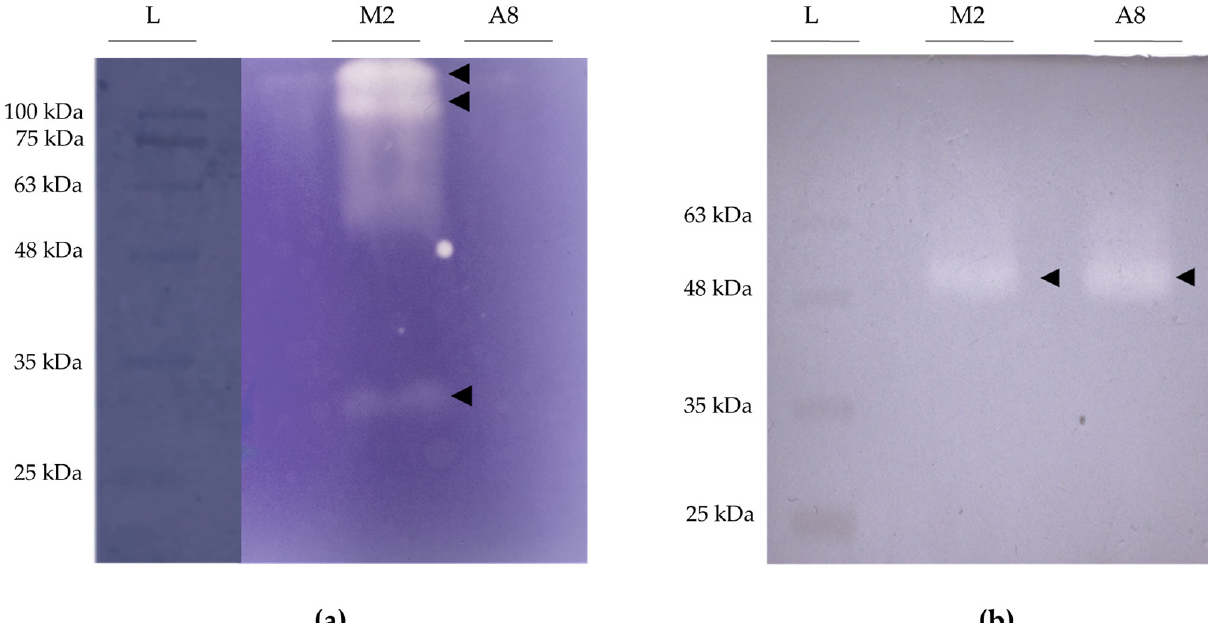
Figure 1. Detection by zymography of proteases and lipases secreted by B. peudobassiana RGM 2184. ( a ) Gel copolymerized with gelatin for the detection of proteases; whitish bands indicate the presence of a protease. ( b ) Gel copolymerized with tributyrin for the detection of lipases; bright bands indicate the presence of lipases. L: ladder lane; M2: enzyme-enriched supernatant extract from RGM 2184 culture in M2 medium; A8: enzyme-enriched supernatant extract from RGM 2184 culture in A8 medium.